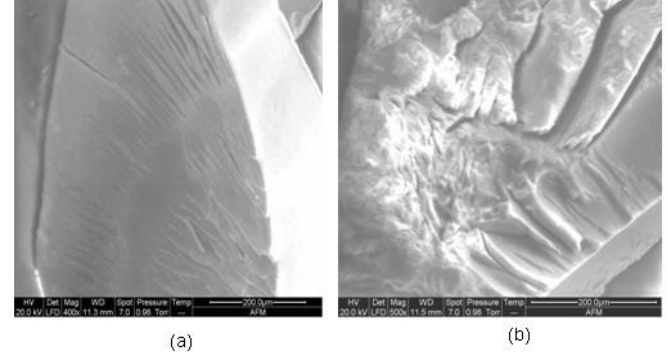
Figure 1 . SEM photographs of AFM resin at different magnification (a=400X, b=500X) Optical